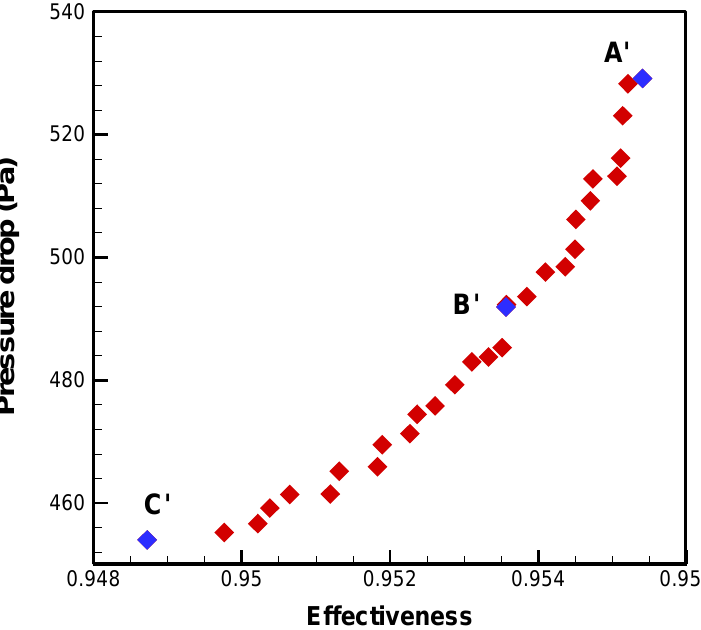
Figure 12. The distribution of solutions of Pareto optimal points using NSGA-II. Table 5. Optimal parameters for the design points A’, B’, and C’ in the Pareto optimal front.